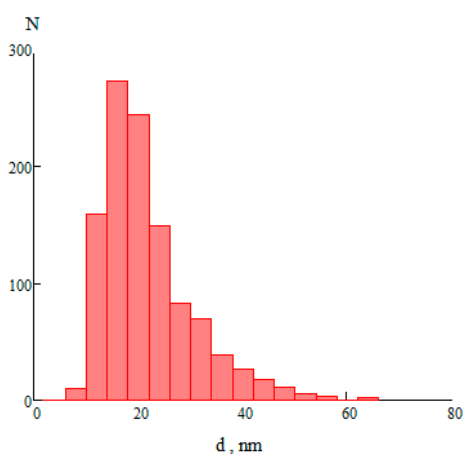
Figure 3. The histogram of the particle size distribution, N is the number of particles, d is the particle diameter.